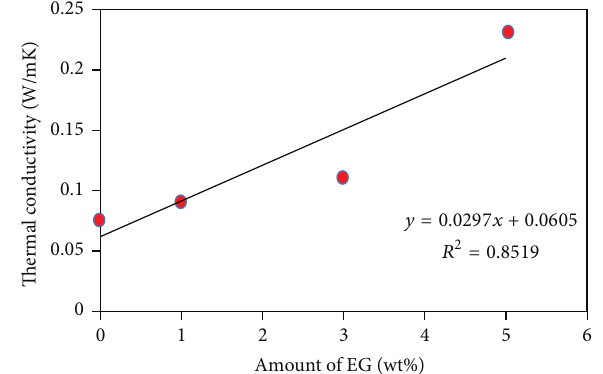
Figure 17: Thermal conductivity of with different EG composite contents.